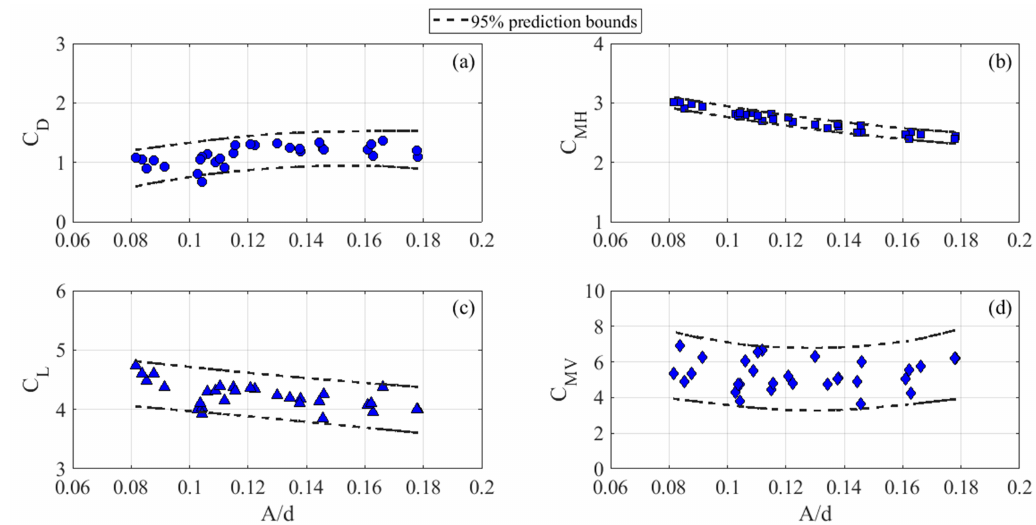
Figure 8. Experimental hydrodynamic coefficients vs. A / d . ( a ) C D ; ( b ) C MH ; ( c ) C L ; ( d ) C MV